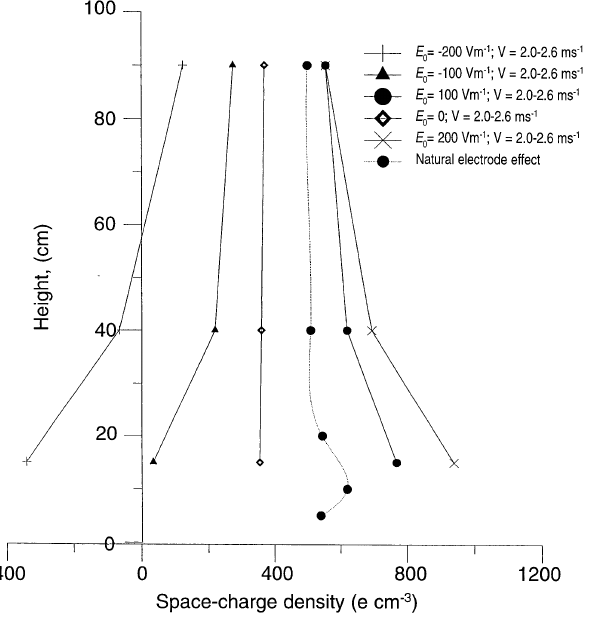
Fig. 3. Mean space-charge density profiles. The dotted curve repres- ents measurements without the